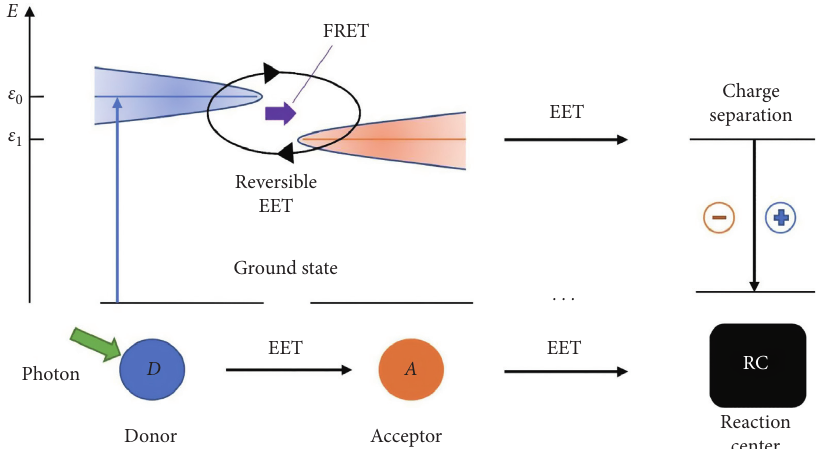
Figure 1: Schematics of the energy transfer process from light-harvesting antenna (the donor) through a chain of acceptor molecules to the reaction center. The excited states of the participating molecules, denoted as ε m , are broadened and they allow for resonance energy transfer via irreversible F¨orster-type resonant process of exciton transfer from donor to acceptor even if ε m ≠ ε m + , which is denoted by the thick 1 arrow labelled FRET. However, if the coupling between the donor and the acceptor molecules is strong enough, the process becomes reversible and the exciton can go to and through many times before it is transferred; this situation is labelled by “reversible EET” and it does not require matching of the energy levels ε m and ε m + 1